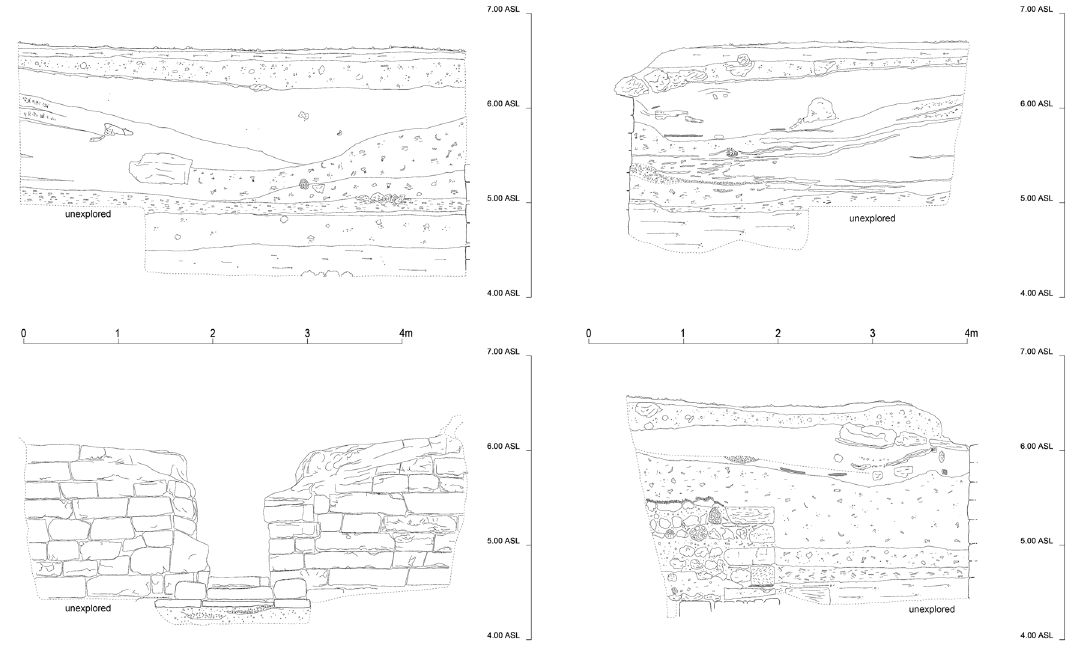
Figure 3: The complex stratigraphy of trench BE19 - 122. Top left – pro fi le N, top right – pro fi le W, bottom left – pro fi le S, bottom right – pro fi le E ( drawing: F. Mi, S Pop ł awski )